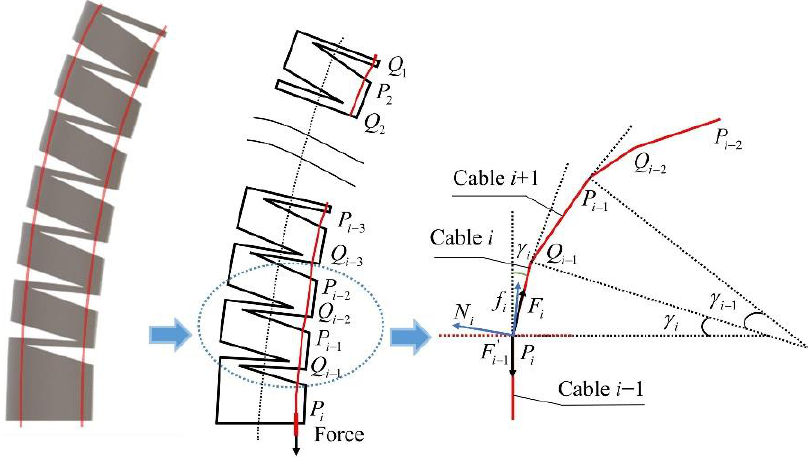
Figure 4. Schematic of NCR being bent under the cable force.